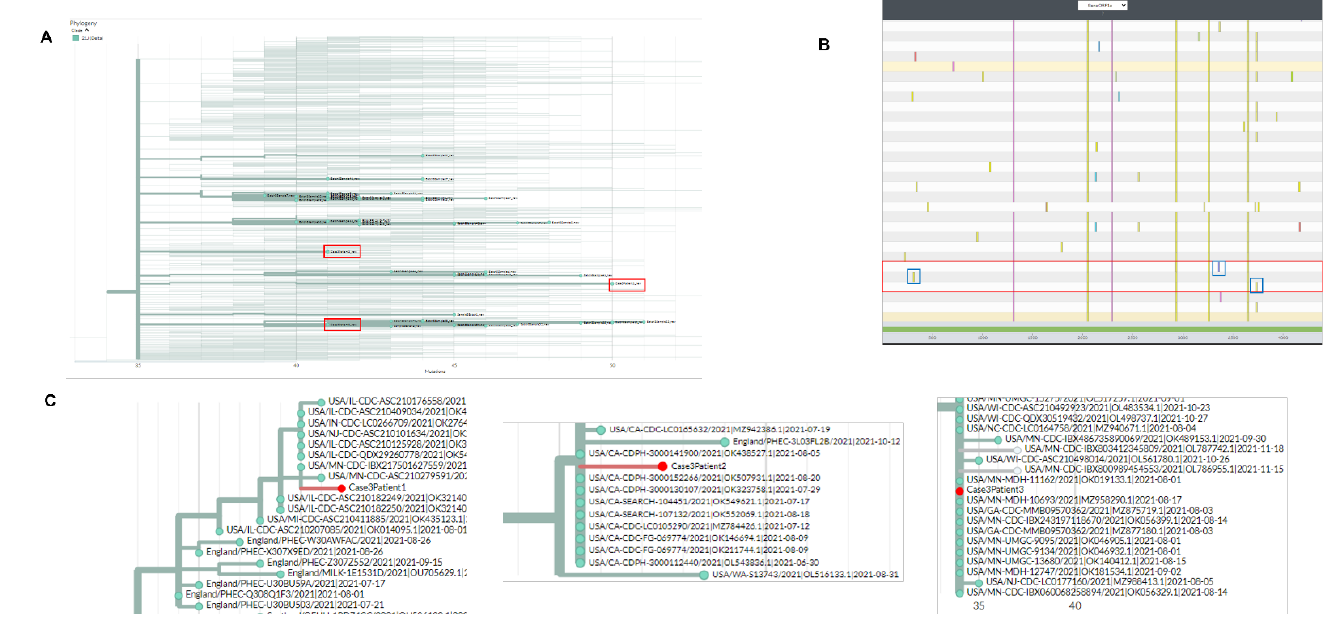
Figure 3. Phylogenetic and molecular analysis for outbreak case-3. ( A ) Nextclade phylogenetic clustering (cases highlighted by red boxes). ( B ) Nextclade gene viewer for CoV-2 ORF1a. Unique mutations are highlighted in red. ( C ) UShER analysis/clustering for outbreak samples with placement near most similar CoV-2 sequences.